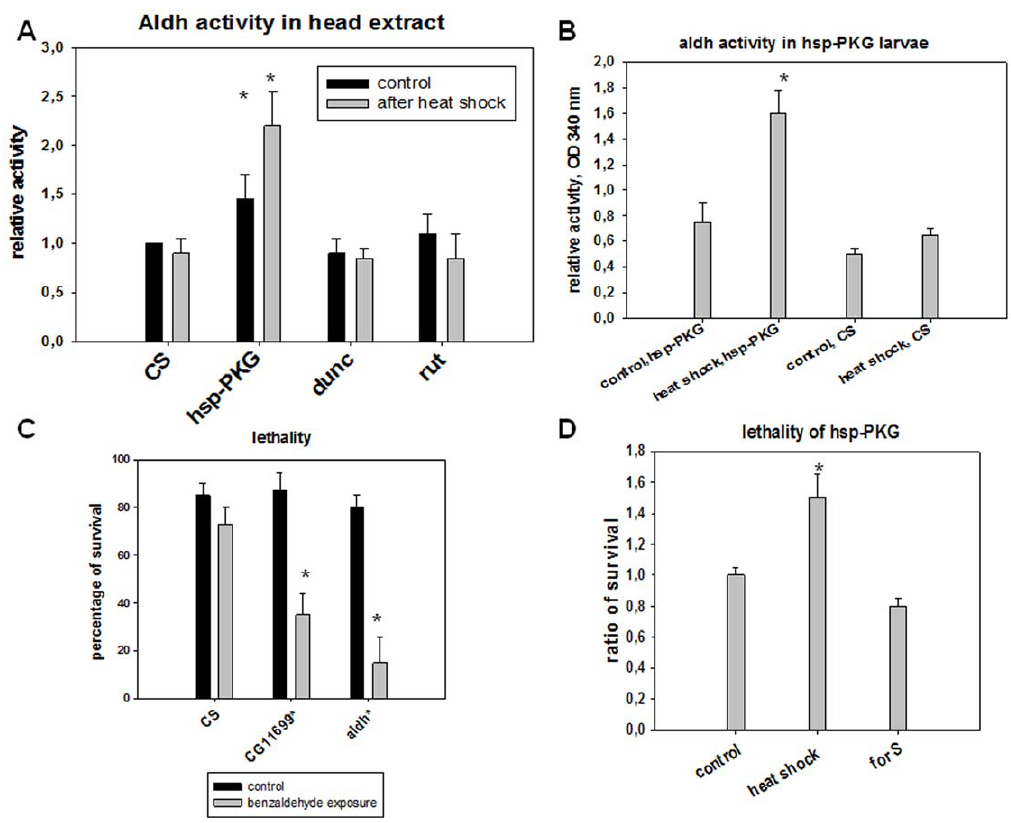
Figure 6. Aldh activity analysis in strains presenting high or low levels of PKA or high levels of PKG and effect of benzaldehyde exposure on the lifespan of flies. (A)Ten flies (female and male), submitted (grey) or not (black) to heat shock, were decapitated andthe membrane head extracts were assayed for Aldh activity using 100 m g of membrane proteins and benzaldehyde as substrate (see Materials and Methods). The dnc mutant has high levels of cAMP due to a defect in phosphodiesterase. The rut mutant presents a low level of cAMP due to a cyclase defect. hsp-PKG is a transgenic fly bearing the for transgene responsible for the dispersion behavior under the heat shock promoter in a Sitter background. The determination obtained with the CS extract was a reference to compare the other strains. Bars are the mean of five experiments + / 2 S.E. *p , 0,001. (B) Aldh activity in third instar larvae in the hsp-PKG strain with or without heat shock prior to the dosage. Bars represent the mean of 3 experiments + / 2 S.E., *p , 0,001. (C) For the lethality, 50 five days old flies (female and male) were exposed to a high concentration of benzaldehyde in a food vial for five minutes (10 m l benzaldehyde deposited on paper) and this was repeated three times on day 5. Lethality was counted one week after. Aldh-III* and CG11699* mutants were assayed versus CS as control. Bars are the mean of five experiments + / 2 S.E., *p , 0.0005 Student’s t -test for benzaldehyde exposure of Aldh-III* and CG11699* versus CS for the heat shock experiments. (D) Third instar hsp-PKG larvae (50 larvae) with or without heat shock were exposed to a high concentration of benzaldehyde (10 m l benzaldehyde deposited on paper, 3 times) in a food vial for one day. Then, the flies that emerged from pupae were counted. Bars are the mean of three separate experiments + / 2 S.E., *p , 0,005 and represent the ratio of surviving adult flies versus the control ( hsp-PKG without heat shock). The for S strain is shown as the background in which hsp-PKG transgene has been